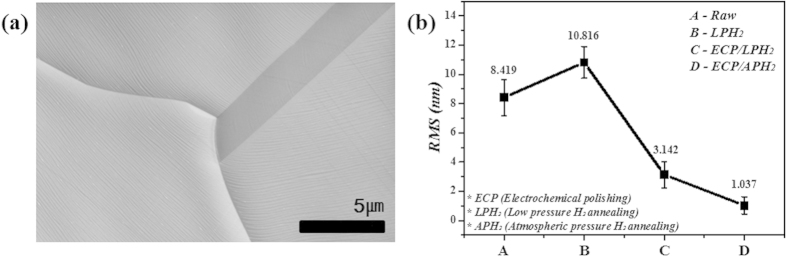
(a) A SEM image of the Ni foil with ECP/APH2 and (b) the RMS comparison of the Ni foil samples measured by AFM: A-the raw Ni foil, B- the Ni foil with LPH2, C-the Ni foil with ECP/LPH2, D-the Ni foil with ECP/APH2.